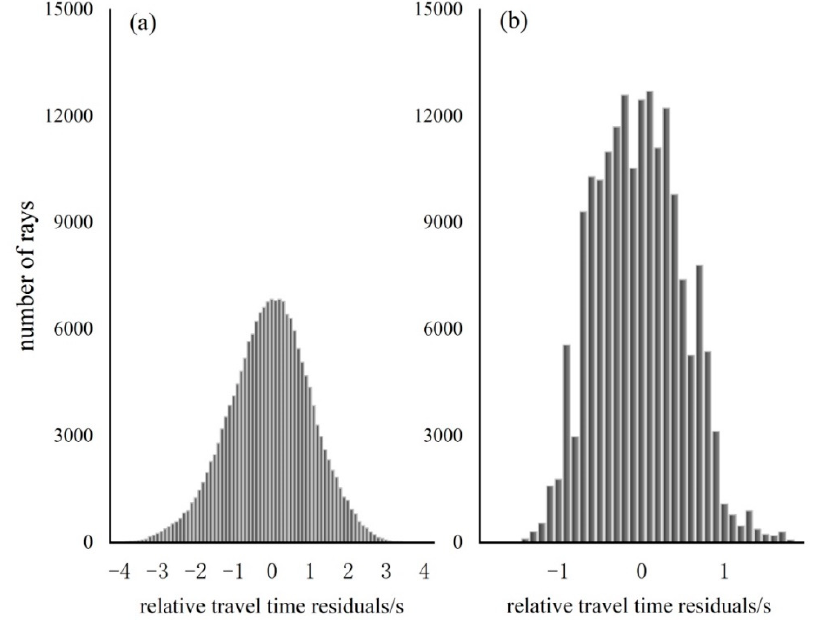
Figure 10. ( a ) Histogram of the relative travel time residuals distribution before inversion. ( b ) Histogram of relative travel time residuals distribution after inversion.